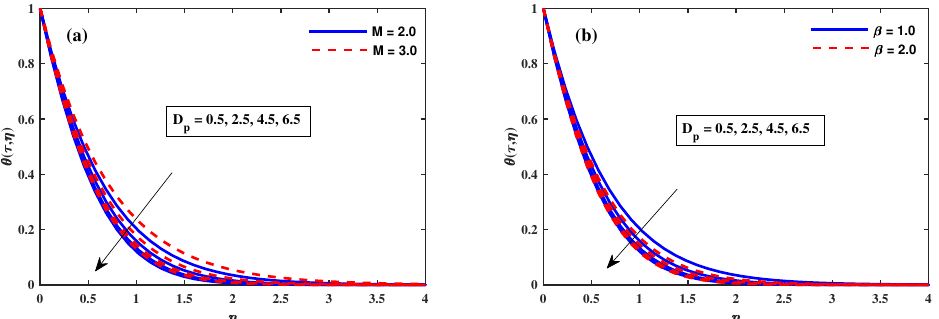
Figure 4. Curve of θ ( τ , η ) against D p (nanoparticle radius), ( a ) M (magnetic field), and ( b ) β (material parameter).